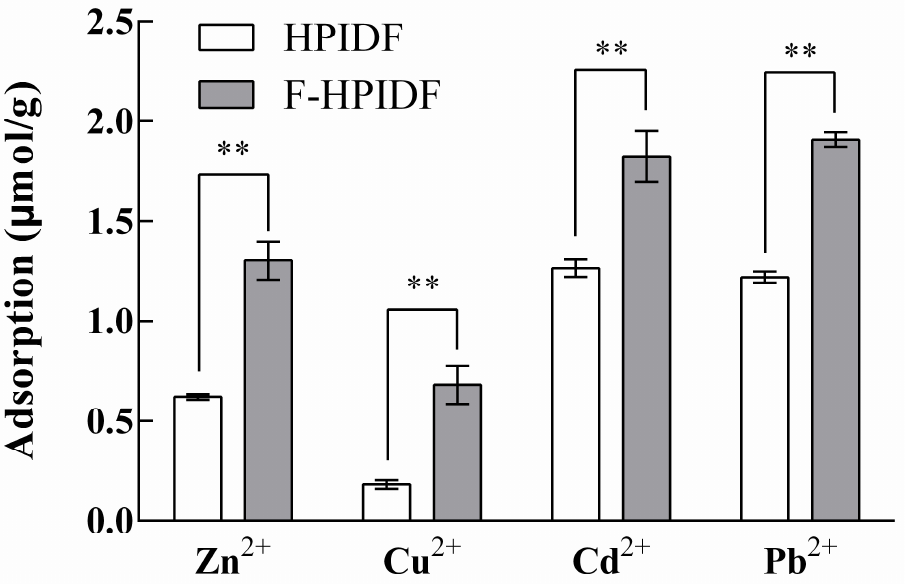
Figure 7. Heavy metal-adsorption capacity of HPIDF/F-HPIDF. (**: p <